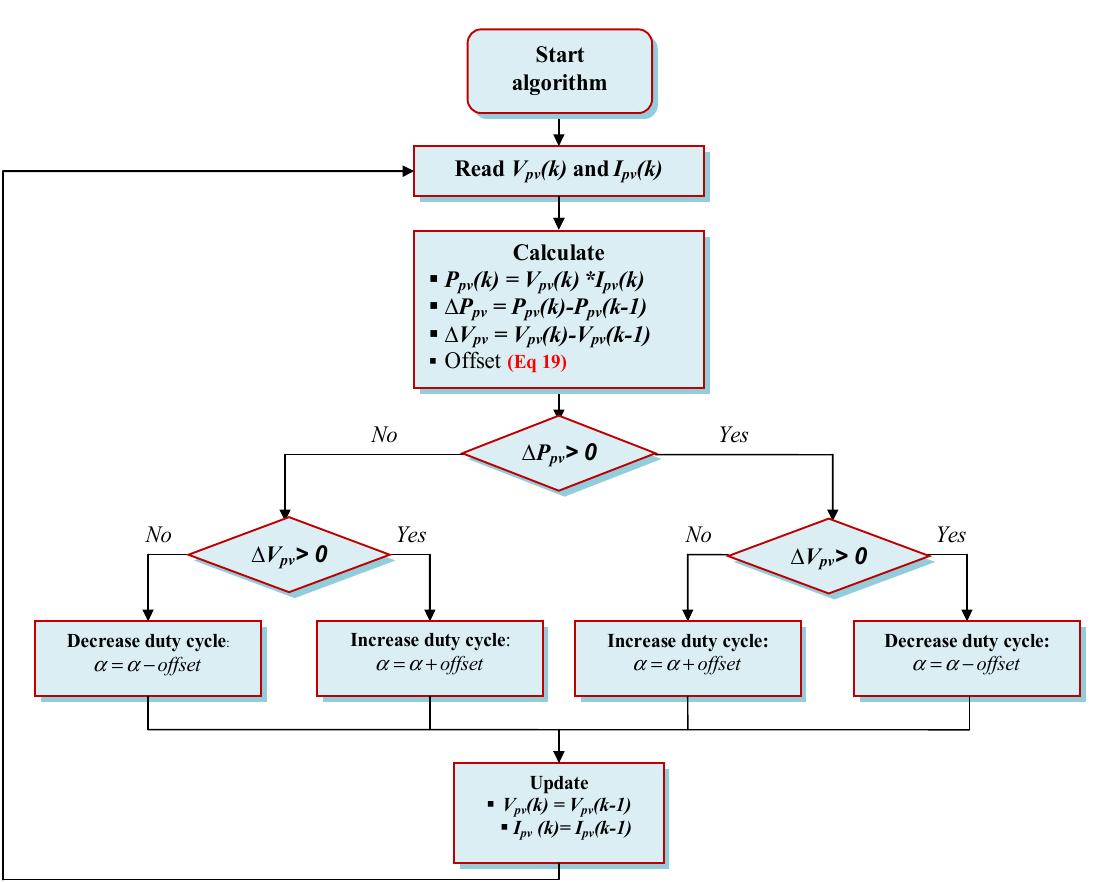
Figure 6. Flowchart for VSS P&O.